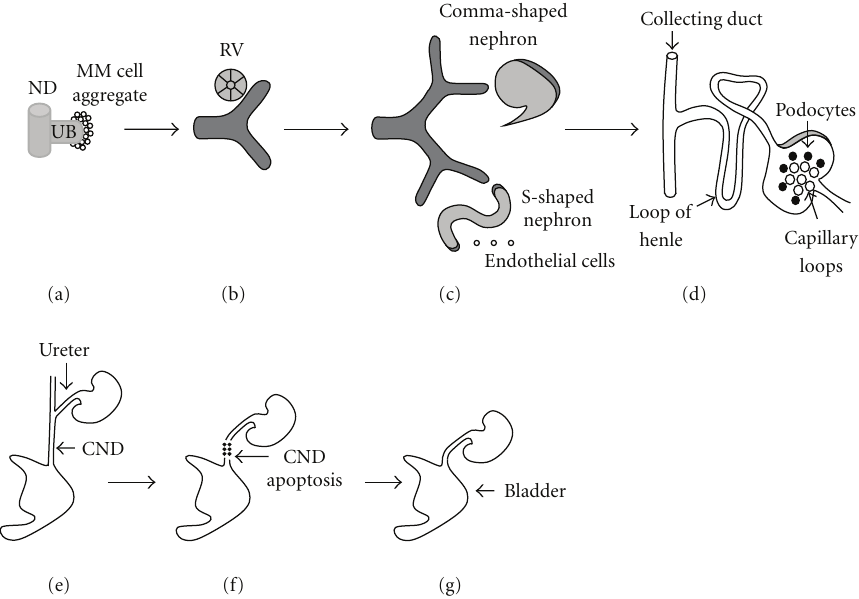
Figure 1: Schematic representation of normal development of the kidney and urinary tract. (a): Invasion of the metanephric mesenchyme (MM) by the ureteric bud (UB) on weeks 5-6 of gestation induces MM cells to aggregate around the UB tip. (a)–(c): UB outgrowth from the nephric duct (ND), its subsequent iterative branching (branching morphogenesis), and continuous condensation of the MM cells around emerging UB tips are induced primarily by reciprocal interactions among glial-derived neurotrophic factor ( GDNF ), its receptor c-Ret, and coreceptor GFR α 1 . (b): MM cell aggregates undergo mesenchymal-to-epithelial transformation (MET) to form the renal vesicle (RV) on weeks 6–36 of gestation. (c): RV elongates along the proximal-distal axis to form comma-shaped and then S-shaped nephron. Distal ends of S-shaped nephrons fuse with UB-derived collecting ducts, whereas proximal clefts form glomeruli. Endothelial cells migrate into the proximal cleft. UB branching occurs on weeks 6–22 of gestation. Formation of nascent nephrons and their patterning occur on weeks 6–36 of gestation. (d): Patterning of the S-shaped nephron and UB result in formation of mature nephron which contains glomerulat capillary tuft, podocytes, proximal tubule, loop of Henle, distal tubule, and collecting duct. (e). Ureter becomes patent and common ND (CND) fuses with cloaca on weeks 4-5 of gestation. (f): Apoptosis of the CND accounts for the positioning of the ureter (derived from proximal UB) in proximity of the urogenital sinus on weeks 5-6 of gestation. (g): Ureter fuses with the bladder by 6 weeks of gestation (with kind permission from Springer Science + Business Media: [82]). Please see text for